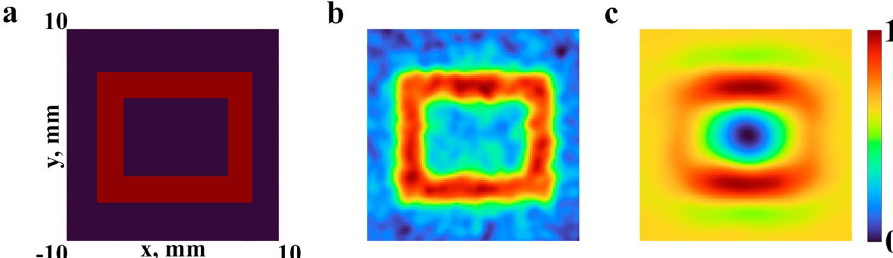
Figure 7. Results of a numerical experiment for ghost imaging. Reference object ( a ), reconstructed images from data with a wide spectrum for 10 thousand realizations using a speckle pattern with correlation coefficients equal to 0.01 ( b ) and 0.9 ( c